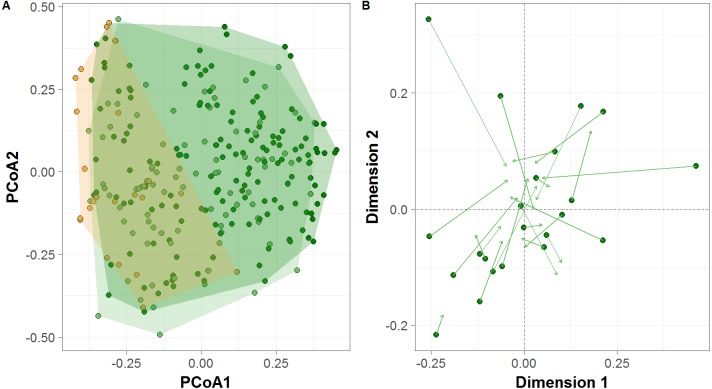
Terrestrial vertebrate species composition in Amazonian seasonally-flooded and unflooded forests during both high- and low-water phases of the flood pulse.(A) Principal Coordinates Analysis (PCoA) ordination of the terrestrial vertebrate assemblage structure detected by camera traps in Amazonian terra firme forests during both high- and low-water phases of the flood pulse (green and light-green circles, respectively) and in várzea forests (orange circles). (B) Procrustes rotation plot of terra firme sites sampled during both high- and low-water phase of the flood pulse. Arrows (vectors) indicate the species migration in community space from the high- to the low-water season.